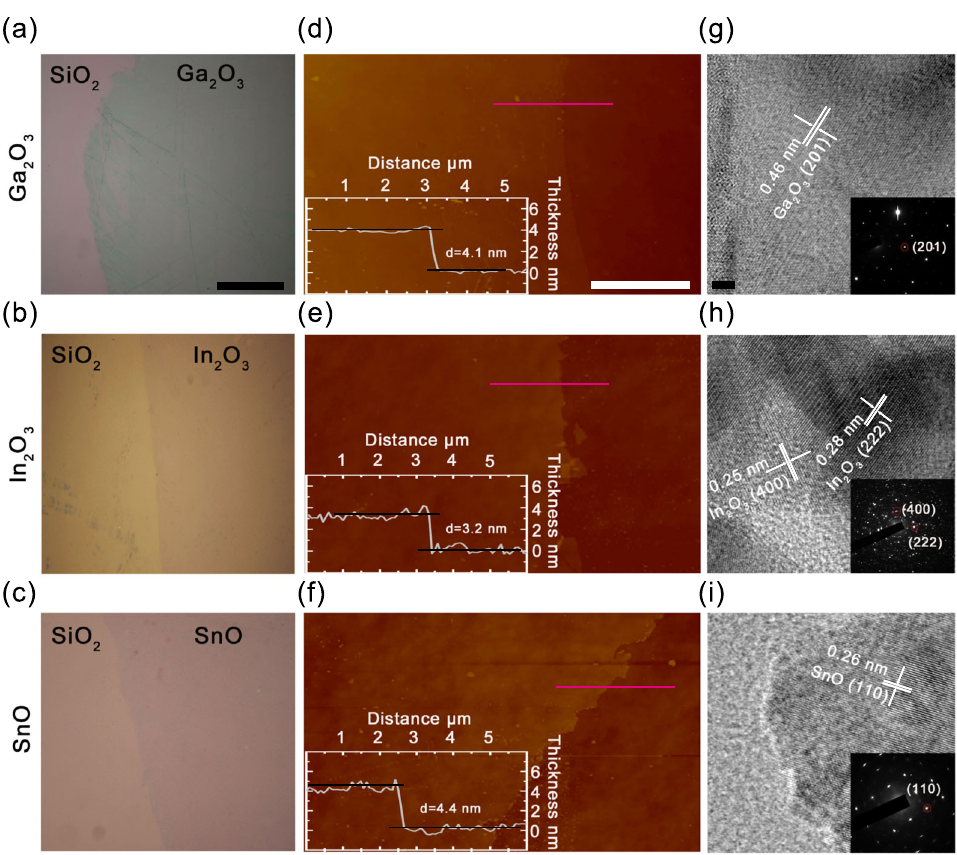
Fig. 2 Morphological and crystalline characterizations of the print 2D semiconductors. a – c optical images exhibit homogeneous fi lms featuring lateral dimensions spanning multiple centimeters (scale bar, 0.5 mm). d – f AFM illustrations, with thickness pro fi le (inset) speci fi ed at the red line as illustrated (scale bar, 5 μ m). g – i TEM characterization of the print semiconductors, including HRTEM images (scale bar, 0.5 nm) and SAED pattern of the corresponding region (bottom